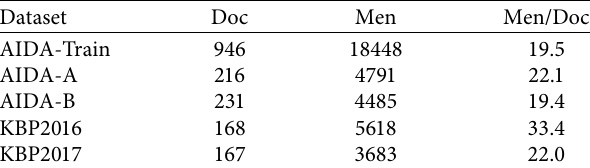
Table 1: Dataset statistics.